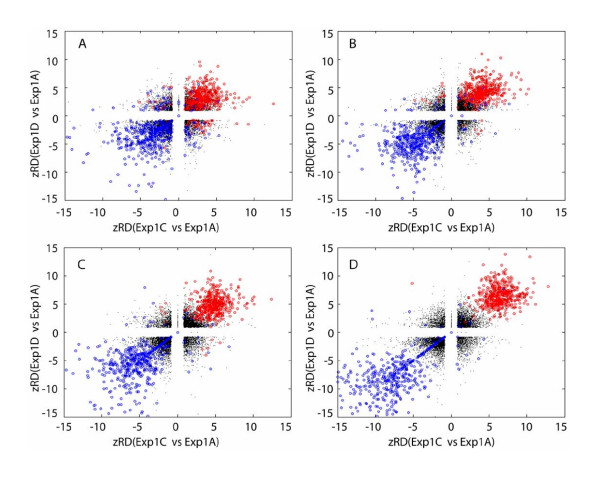
plot of zRD of the comparison Exp1D vs Exp1A against zRD of the comparison Exp1C vs Exp1A. Exp1C and Exp1D are synthetic data sets made from the experimental replicates Exp1A and Exp1B (sh100 at t = 0 h). As zRD can be negative, we have plotted positive variations as zRD+2 and negative variations as -zRD-2 to obtain a clear separation of increased and decreased genes. All of the unchanged genes have their zRD set to zero. Red and blue circles mark the genes that received, respectively, an increasing (500 genes) or decreasing (500 genes) additional variation contribution. Black points mark all the genes that did not receive an additional variation contribution. The additional variation p-value was set to 0.30 (A), 0.10 (B), 0.05 (C) and 0.01 (D).